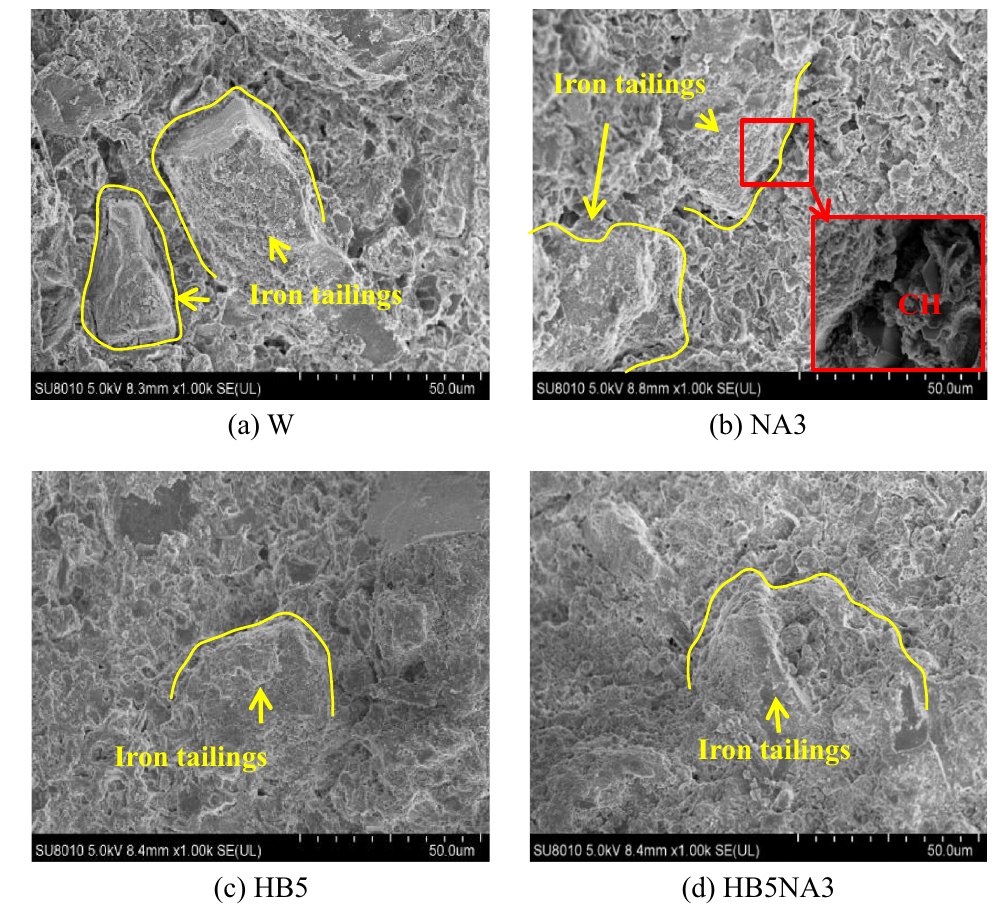
Fig. 17 Morphology of the cement paste with different iron tailings